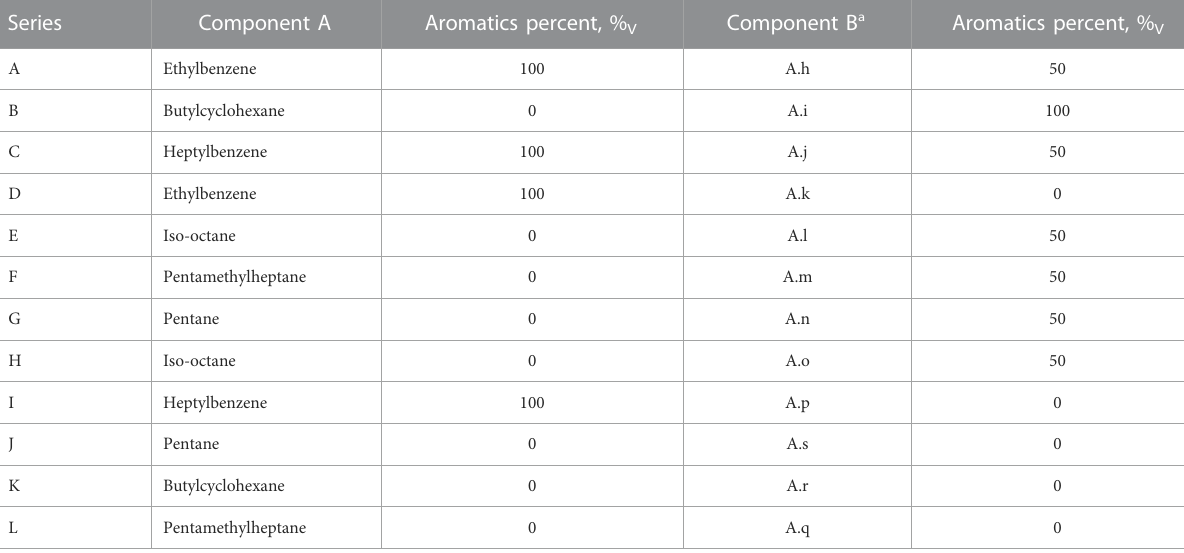
TABLE 5 Components of type B, tertiary mixtures.